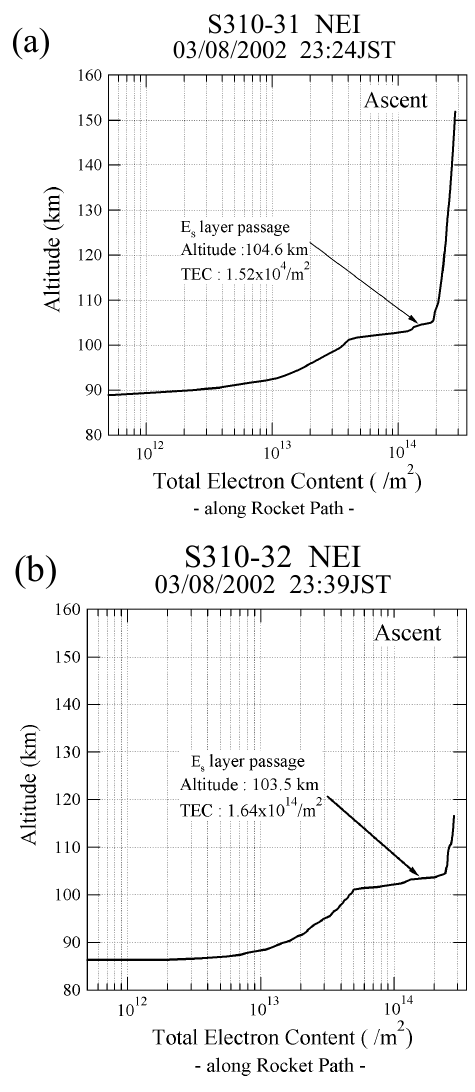
Fig. 8. (a) and (b) The integrated values of electron density profiles obtained by the NEI on board S310-31 and S310-32, respectively (integration is performed from the ground in each